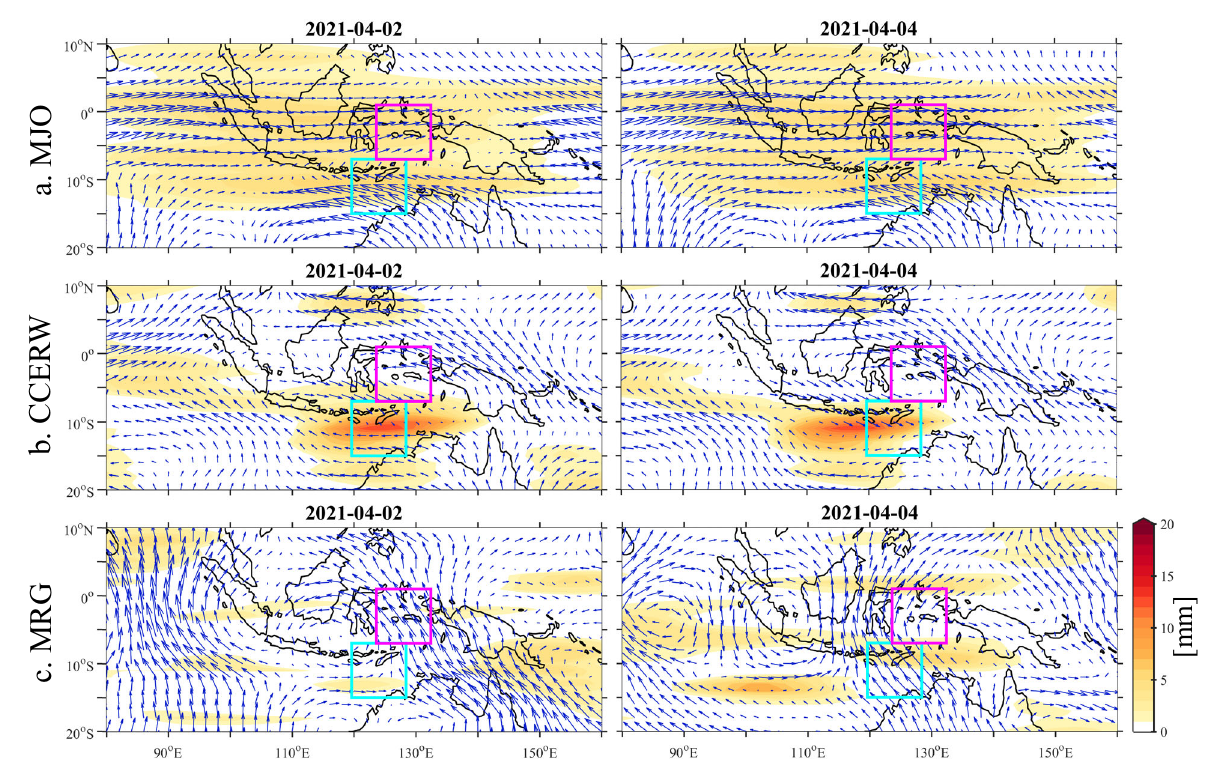
Fig. 3 | Time evolution of GPM precipitation anomalies (shaded) and ERA-5 850hPa wind anomalies (arrows) during the TC Seroja genesis. Wavenumber- frequency fi ltered anomalies for a Madden-Julian Oscillation, b Convectively